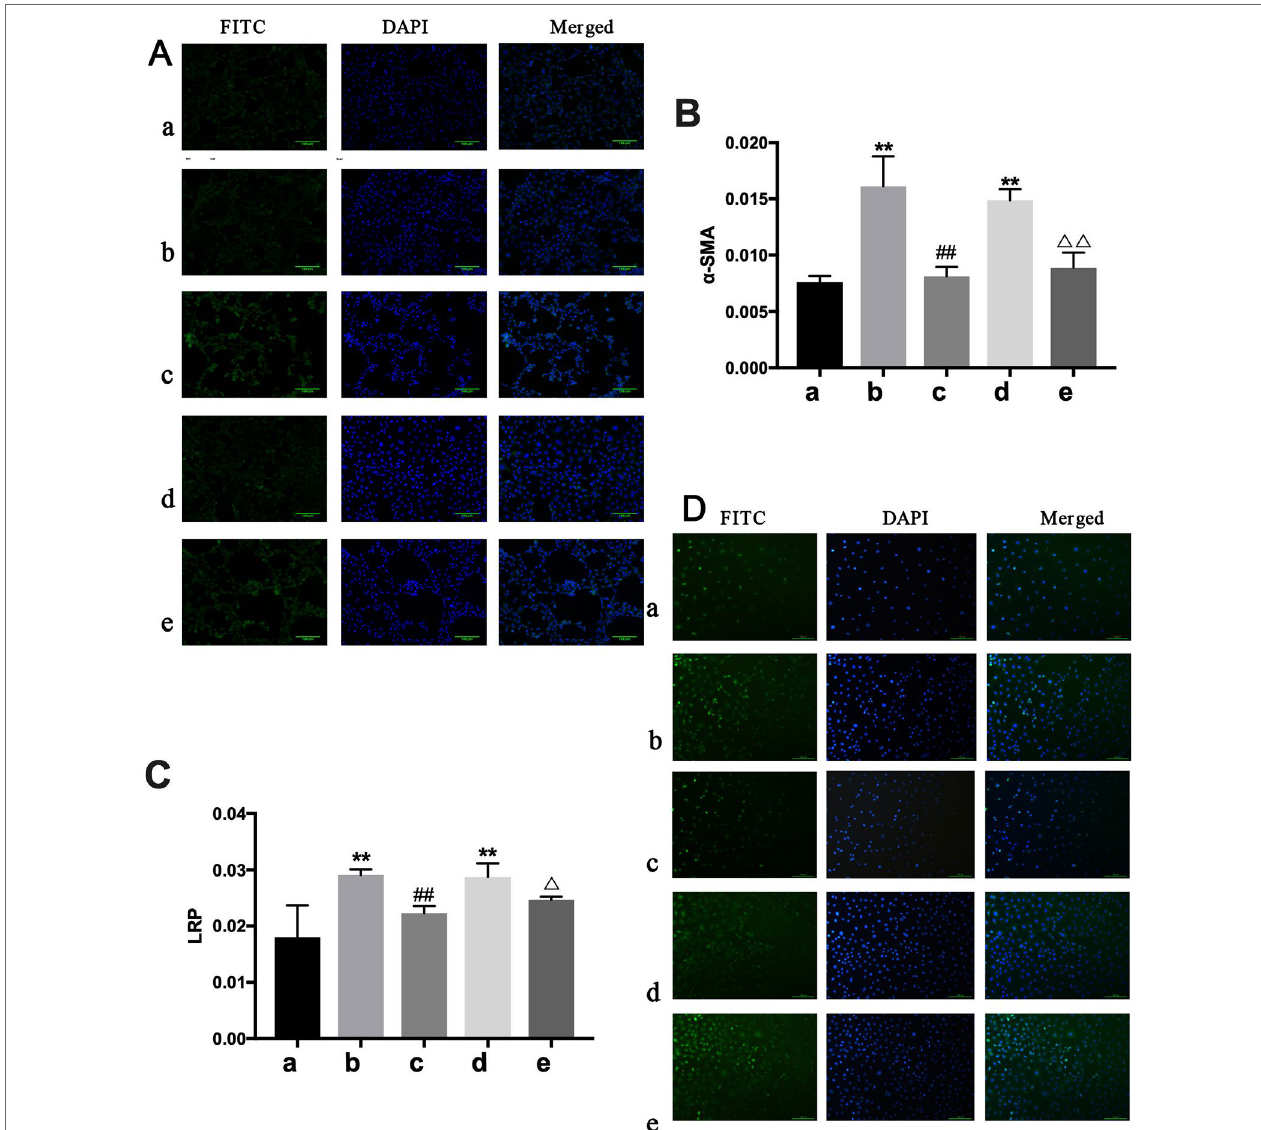
FIGURE 8 | Determination of α -SMA and LRP in NREK-52E cells. FITC, fluorescein isothiocyanate. DAPI, 4 ′ ,6-diamidino-2-phenylindole. CTGF, connective tissue growth factor. BXYS, Buxin Yishen decoction. CHF, chronic heart failure. a: BLANK group. b: BLANK+CTGF group. c: CTGF+BXYS group. d: CHF group. e: CHF+BXYS group. **P < 0.01 vs. BLANK group. ## P < 0.01 vs. BLANK+CTGF group. Δ P < 0.05, ΔΔ P < 0.01 vs. CHF group. ( A and B ) Alpha smooth muscle actin ( α -SMA) expression in cells. ( C and D ) Low density lipoprotein receptor-related protein (LRP) expression in